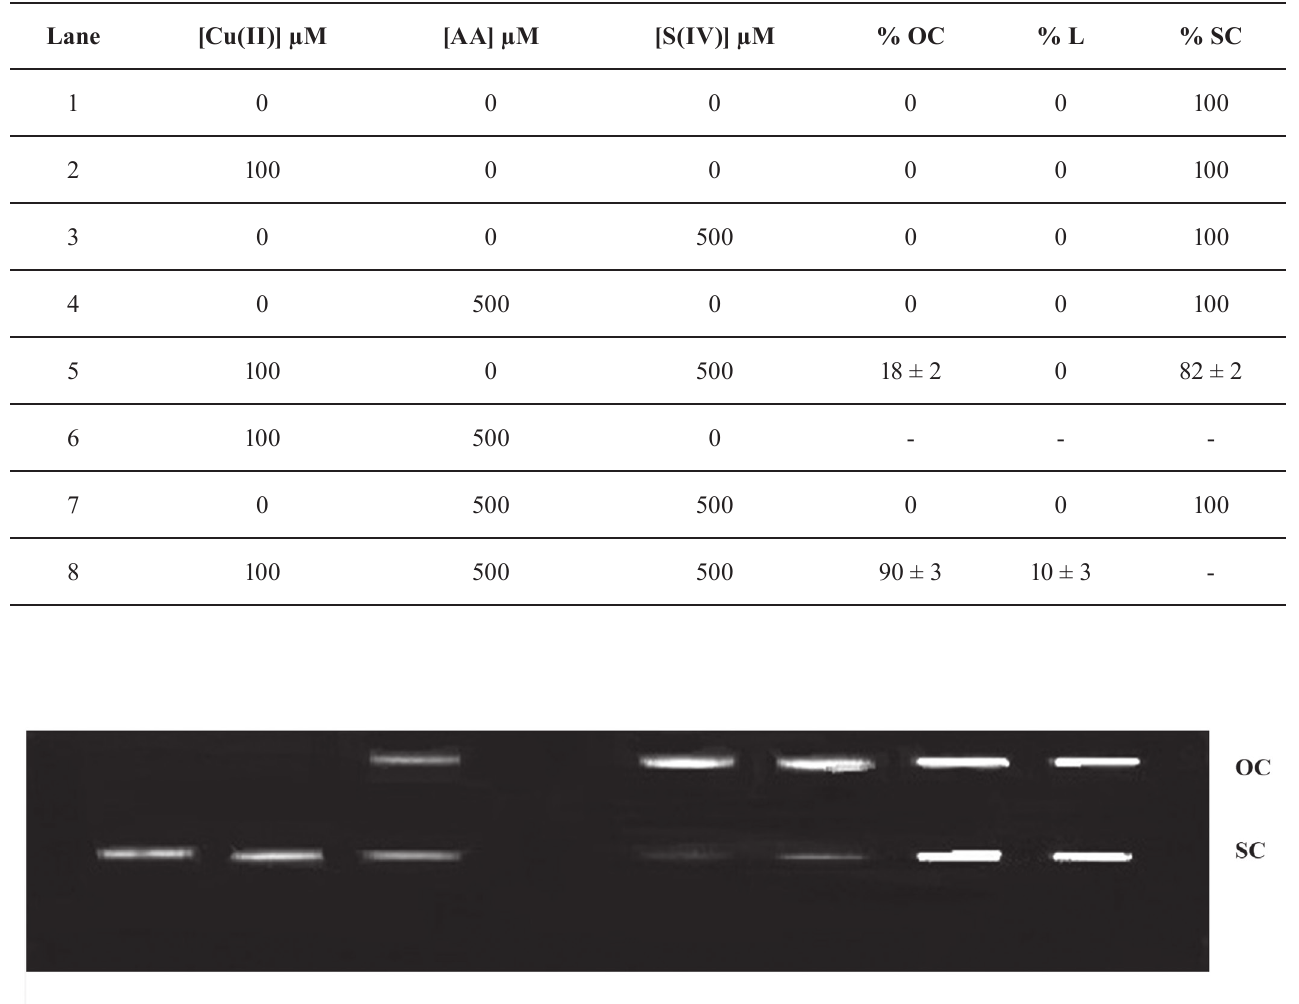
TABLE II – % of OC, L and SC forms of pUC-19 DNA 5.0 ng μL -1 according to the experimental conditions described in Figure 3